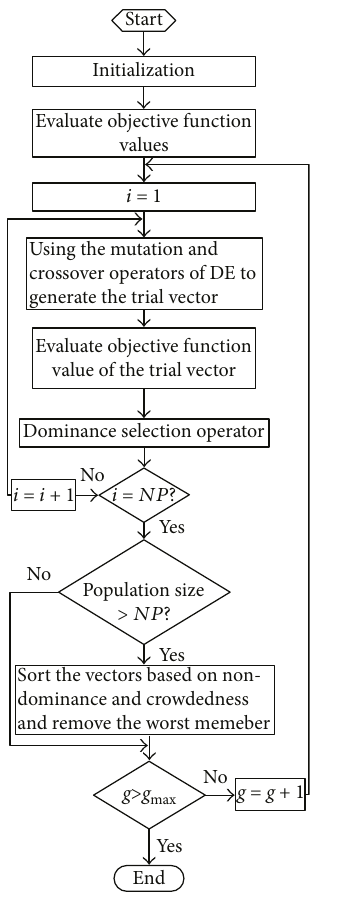
Figure 2: The fl owchart of the GDE3 algorithm.